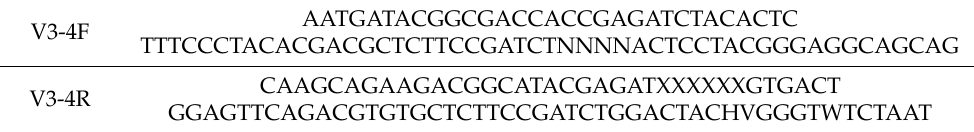
Table 1. V3–V4 region-specific primers for 16s rRNA gene